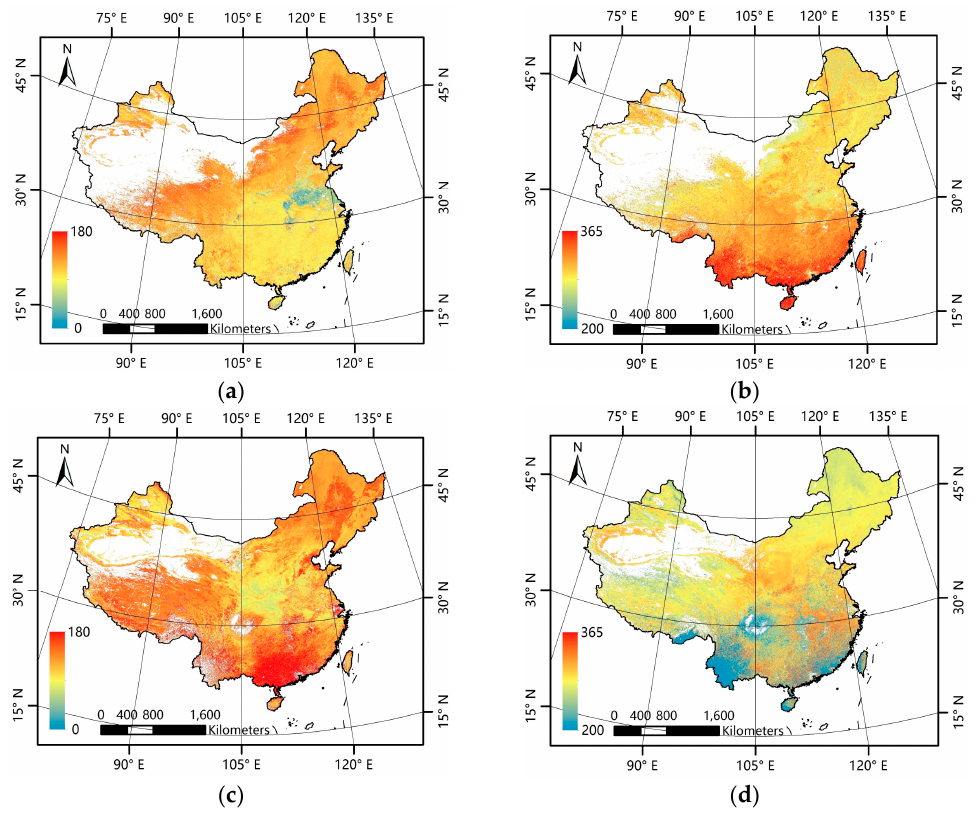
Figure 3. Patterns of mean phenological metrics of the GLP and the MLCD. ( a ) SOS of GLP; ( b ) EOS of GLP; ( c ) SOS of MLCD; ( d ) EOS of MLCD.